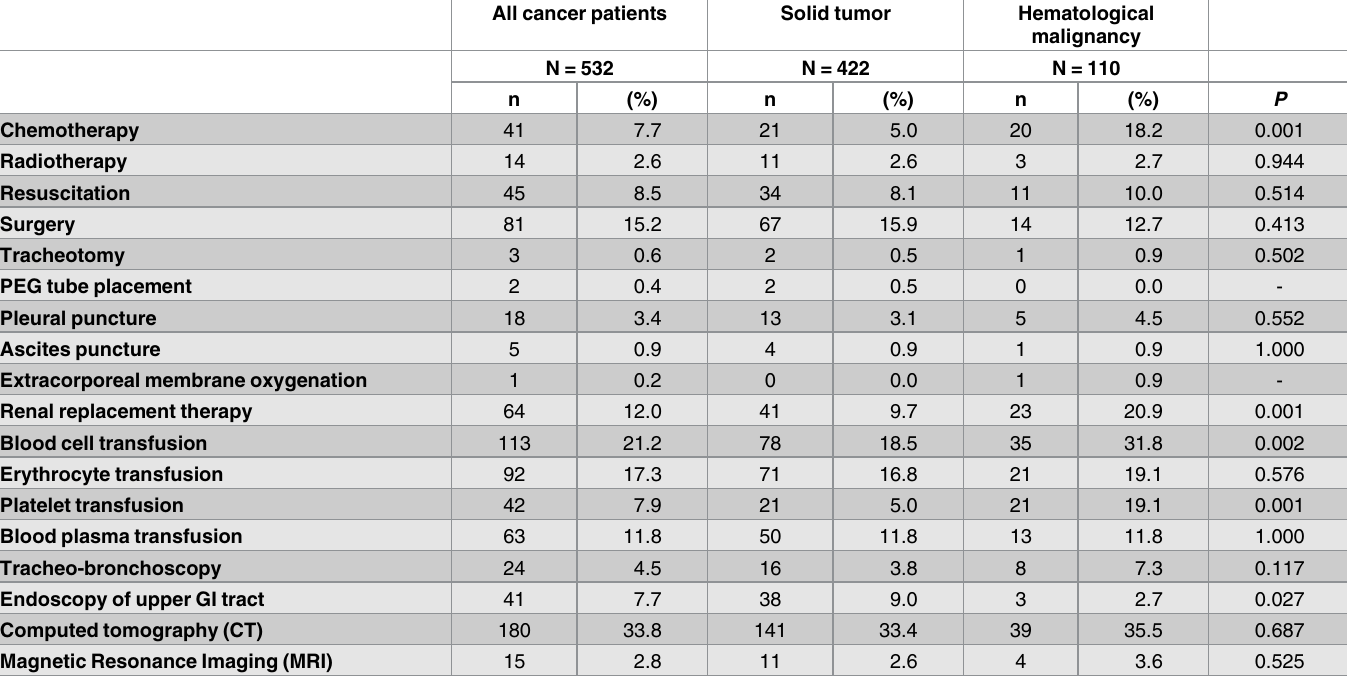
Table 2. Frequencies of medical procedures in cancer patients with malignant solid tumors compared to non-solid tumors in the last week of life. All cancer patients Solid tumor Hematological malignancy N =